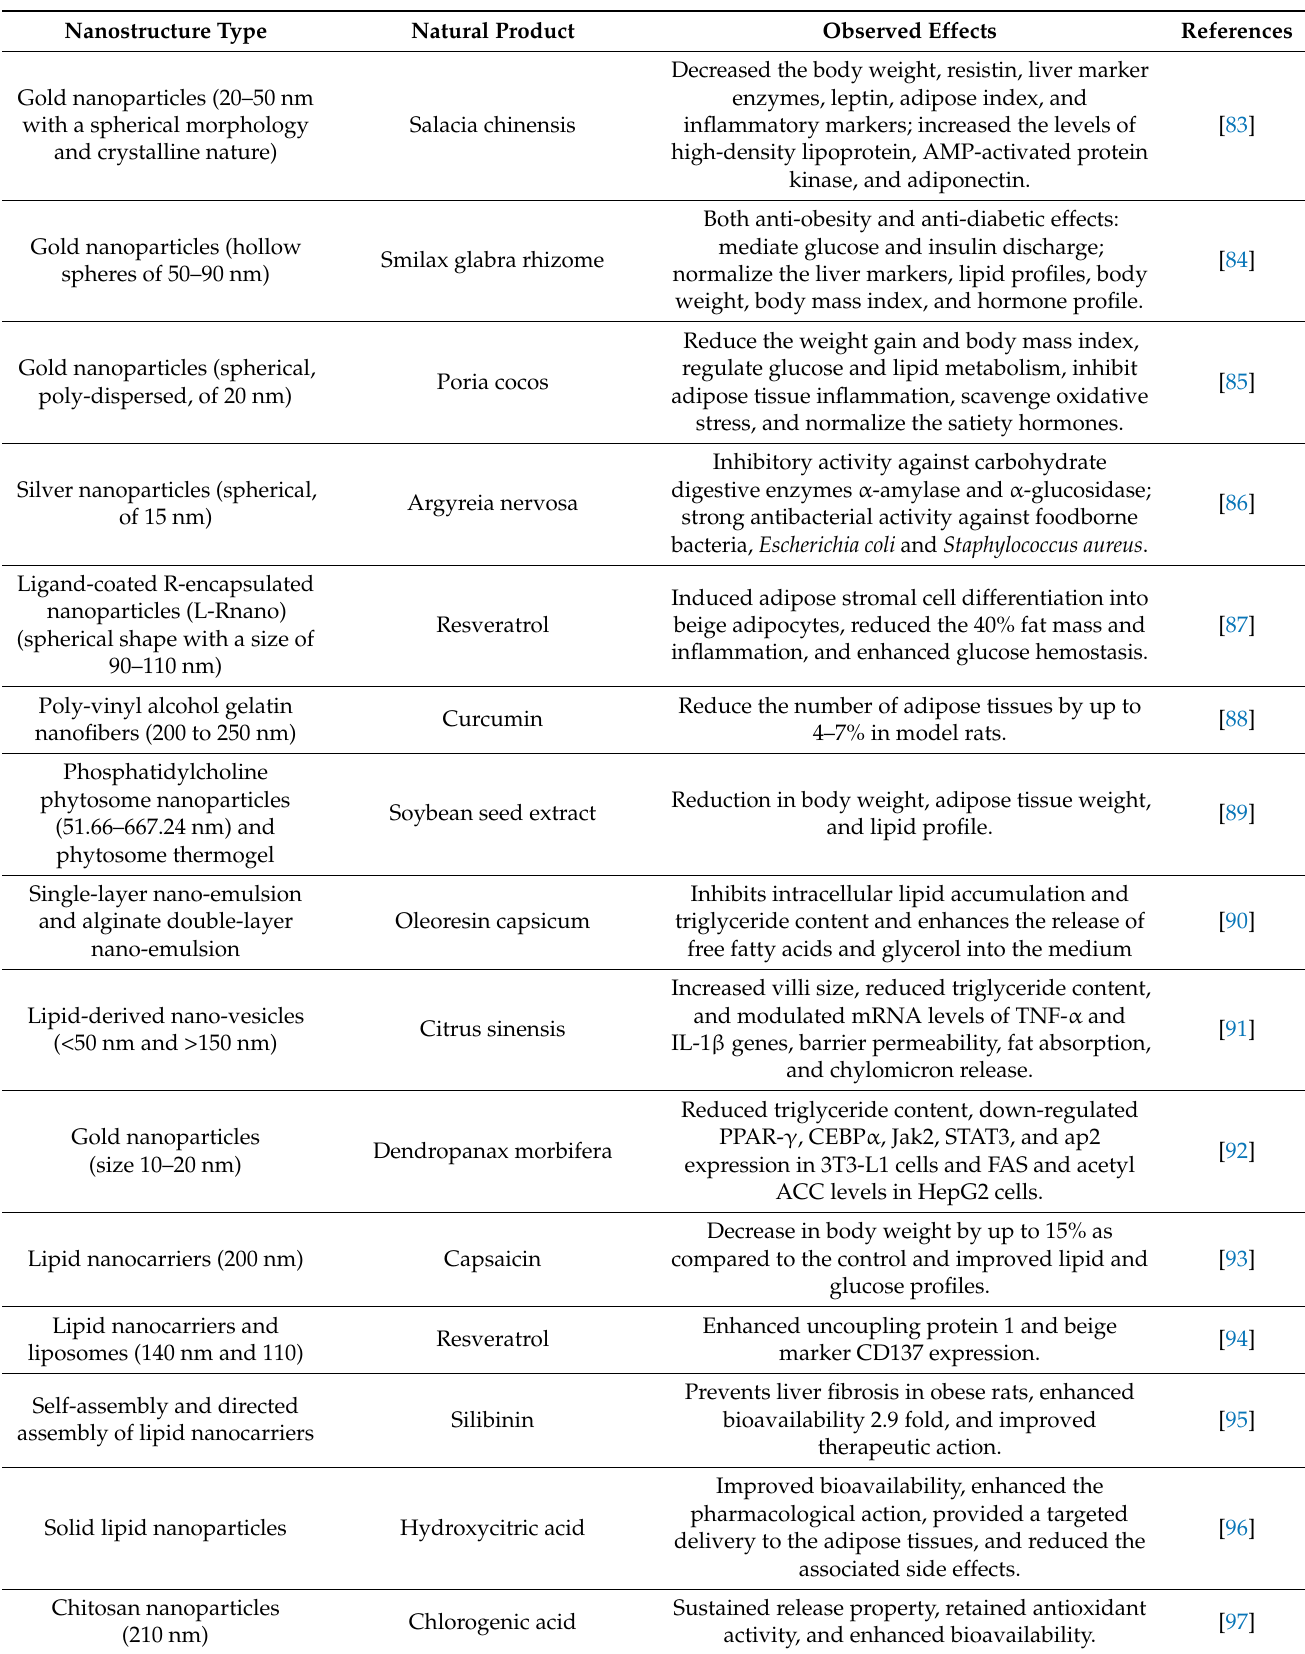
Table 5. Natural anti-obesity nanostructures and their therapeutic roles in the management of